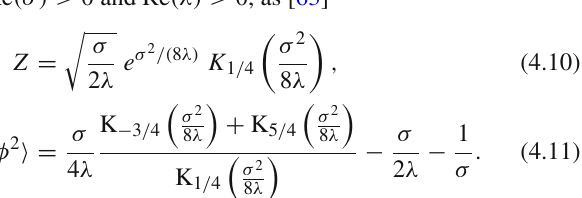
action. sent the thimbles, red dashed curves represent the anti-thimbles, and the grey solid curves represent the ghosts. The shaded regions represent the regions where Re ( S ) ≥